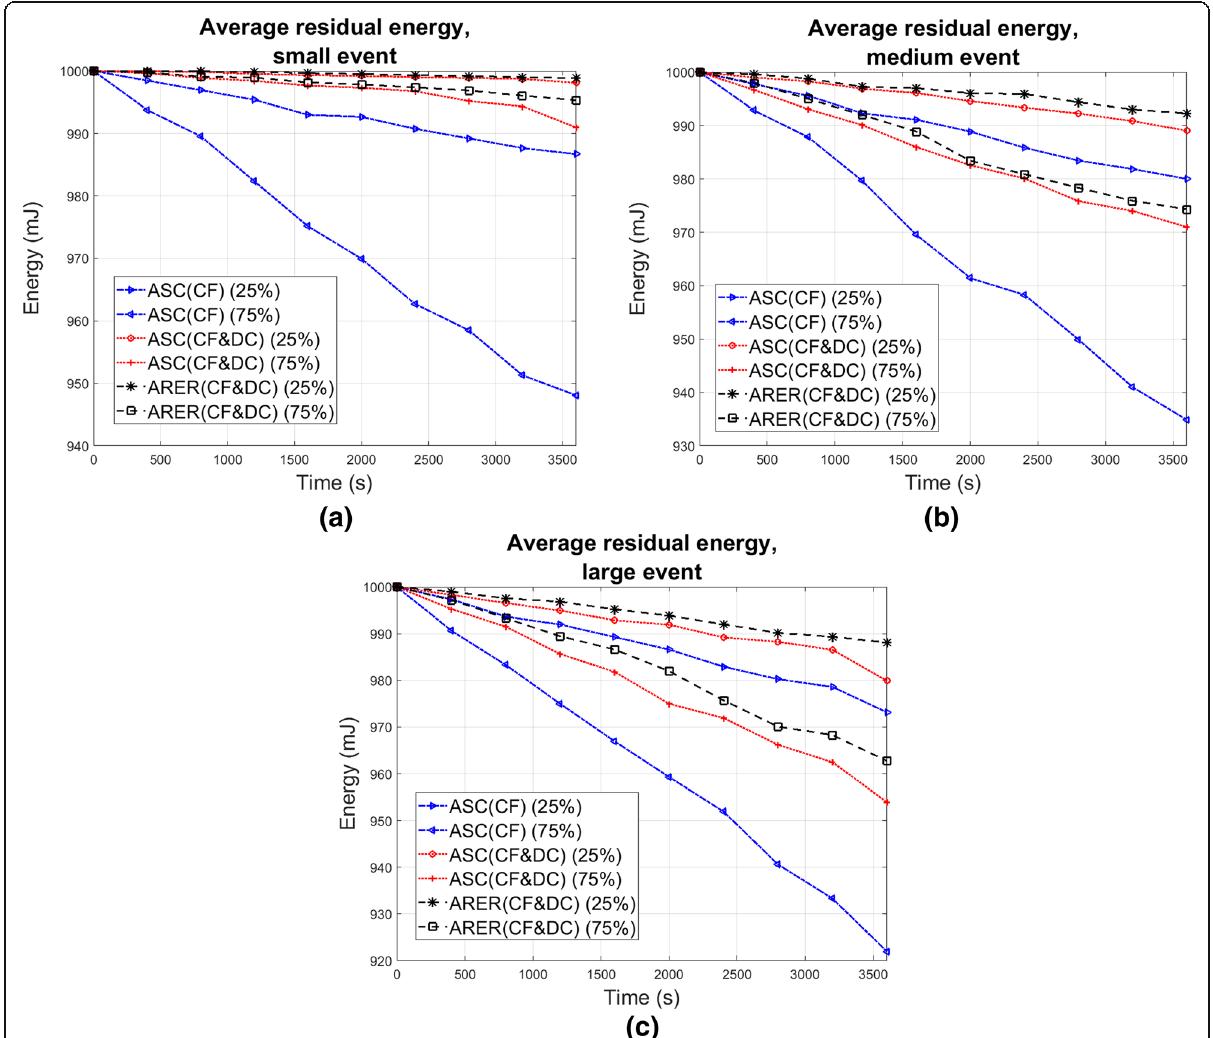
Fig. 6 Average residual energy of the network with different size of the event. a Small event. b Medium event. c Large